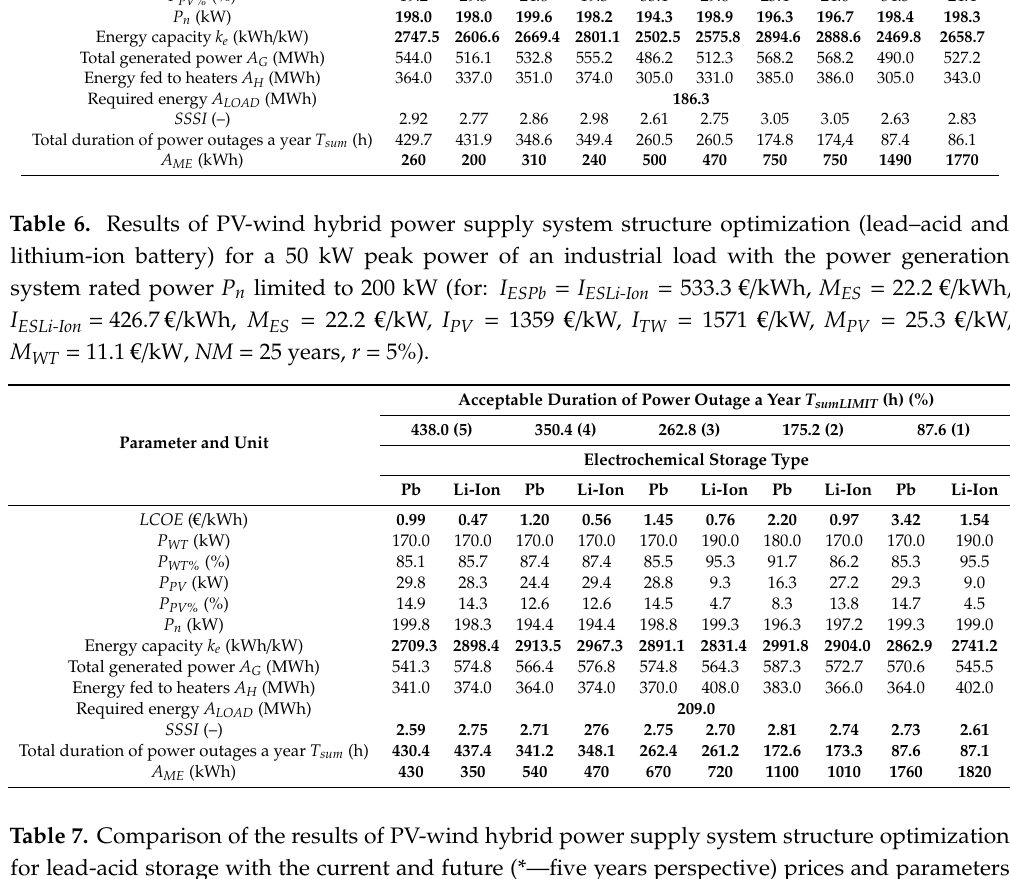
Table 7. Comparison of the results of PV-wind hybrid power supply system structure optimization for lead-acid storage with the current and future (*—five years perspective) prices and parameters for a 50 kW peak power communal load with no limit for the power generation system rated power P n (for: I ESPb = I ESLi-Ion = 533.3 € / kWh, M ES = 22.2 € / kWh, I ESLi-Ion = 426.7 € / kWh, M ES = 22.2 € /